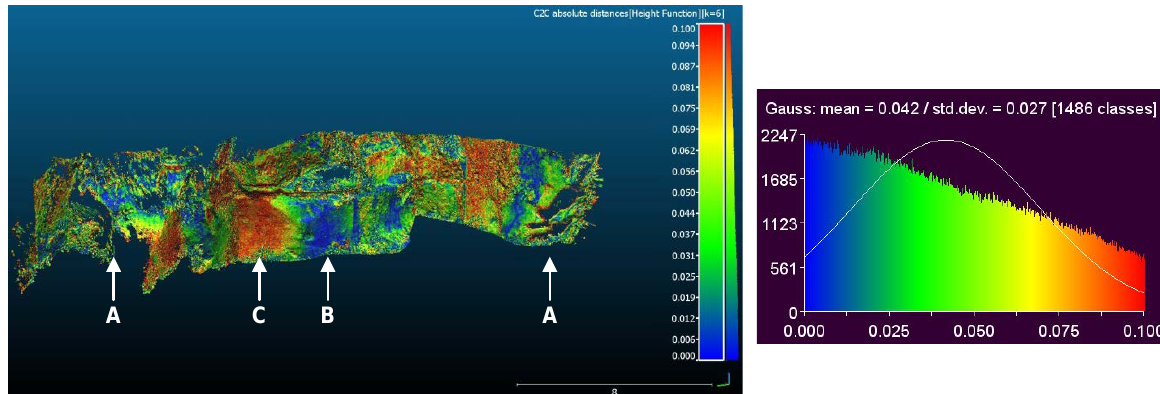
Figure 6. Error mapping of deviation between TLS and GoPro Hero 1080